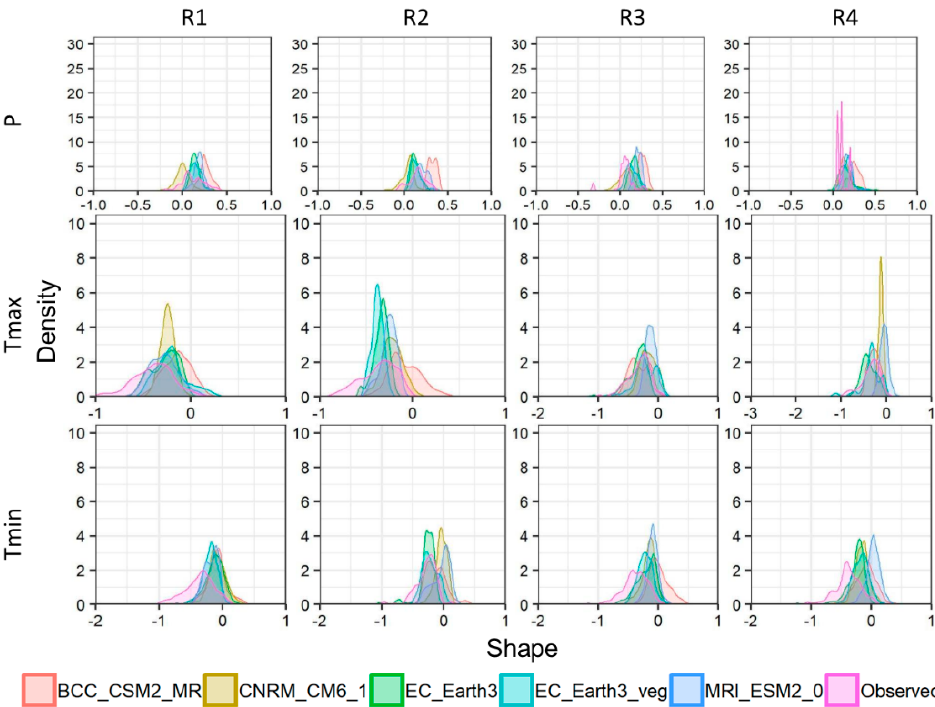
Figure 10. Kernel density curves of the tail index (shape parameter) of P, Tmax, and Tmin extremes corresponding to four climate regions in Alberta for the 1983–2014 period.